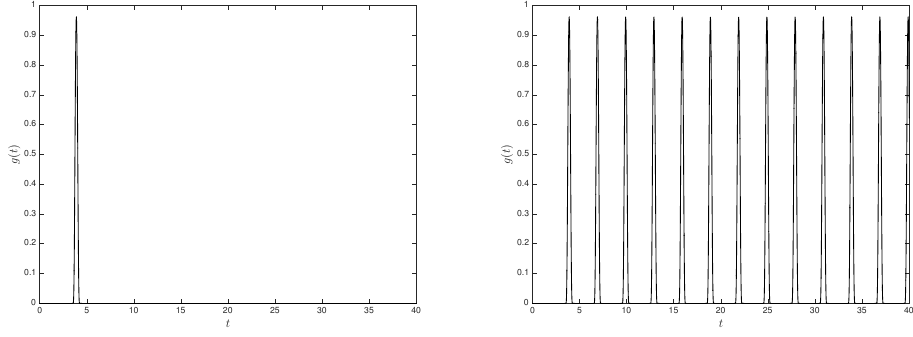
Fig. 5 The Dirichlet boundary conditions used for the 2D spacetime simulations: single pulse and a periodic train of pulses, which will make the solution transition to